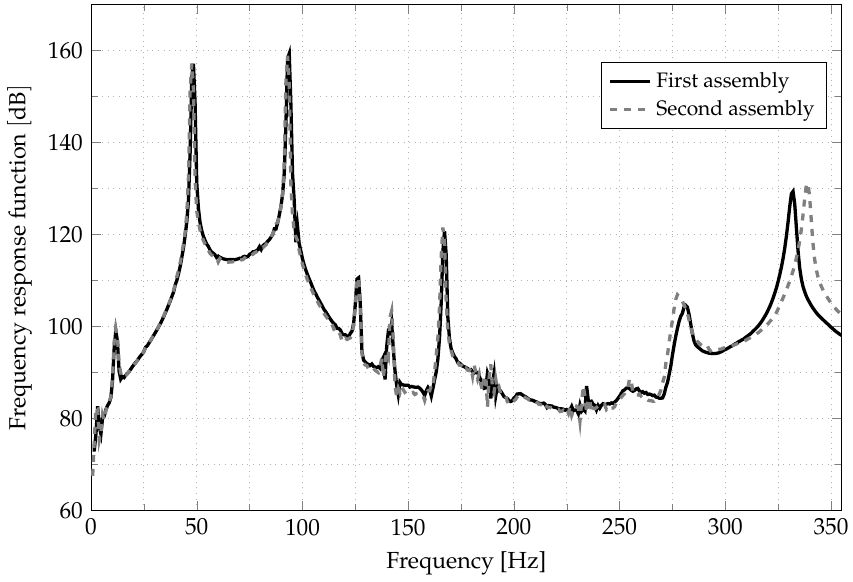
Figure A2. FRF of the test specimen with an empty HCDP mounted between the stator arm and stator ring.